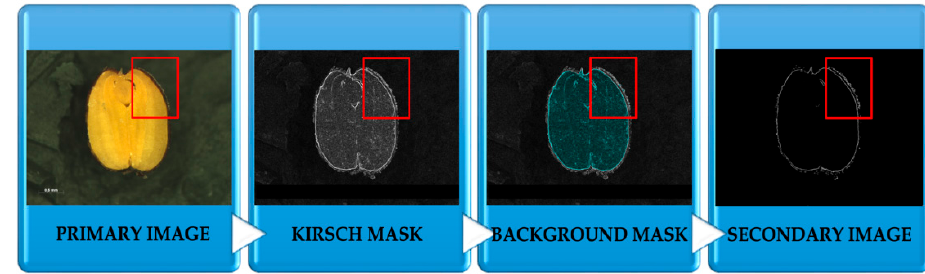
Figure 3. Scheme of secondary image acquisition using image analysis.